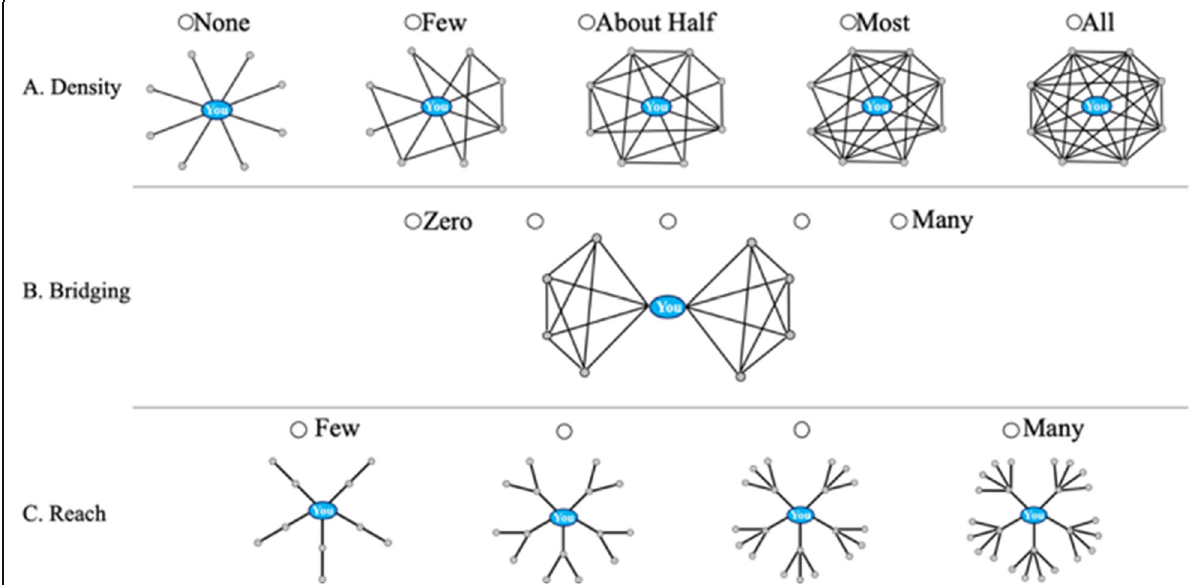
Fig. 1 Visual network scale (VNS) images used to prompt teacher perceptions of their CoP network structures related to a density, or interconnectedness, b bridging (a.k.a. brokerage), or connecting otherwise unconnected contacts, and c reach, or how connected their contacts